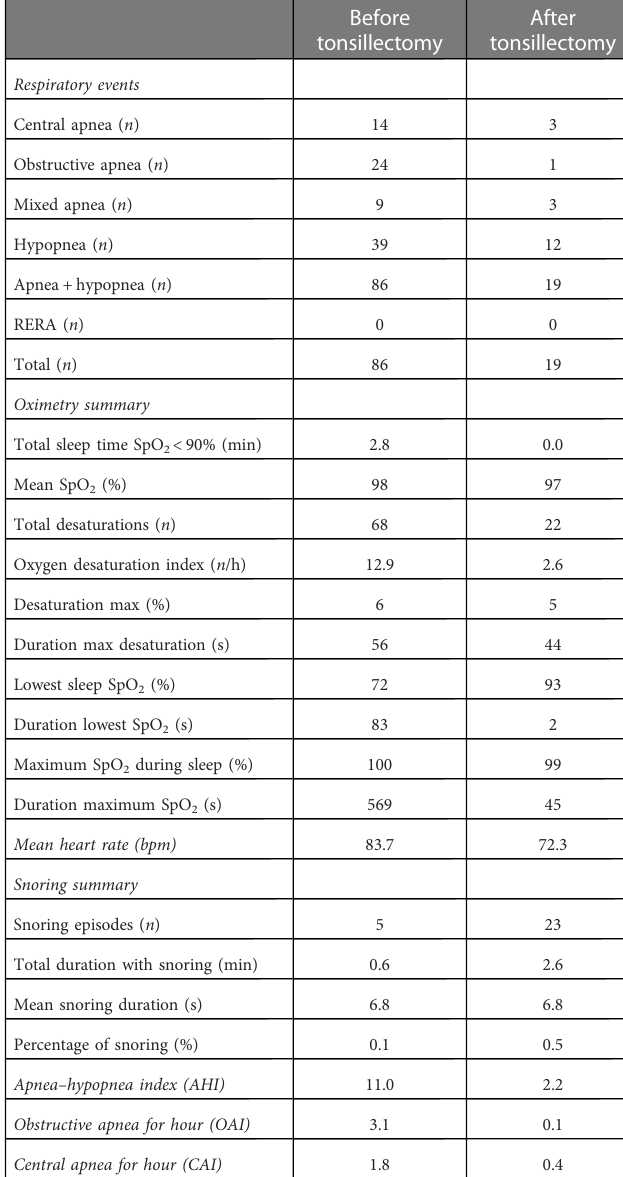
TABLE 1 Polygraphy report before and after the surgical treatment. Polygraphy before surgery lasted 477 min and documented 24 obstructive apneas, 14 central apneas, 39 hypopneas, 9 mixed apneas, and no arousals related to respiratory effort (RERA). The mean oxygen saturation values was 98%, with a minimum of 72%. The percentage of sleep time spent with oxyhemoglobin saturation of less than 90% was 0.6%. Polygraphy (PG) documented severe obstructive sleep apnea syndrome with an apnea – hypopnea index (AHI) equal to 11, 3.1 episodes of obstructive apnea, 1.8 episodes of central apnea in 1 h, and the lowest desaturation value of 72%. Three weeks after surgery, PG lasted 509 min and documented 1 obstructive apnea, 3 central apneas, 12 hypopneas, 3 mixed apneas, and no RERA. The mean oxygen saturation values was 97%, with a minimum of 93%. PG showed a substantial reduction of AHI